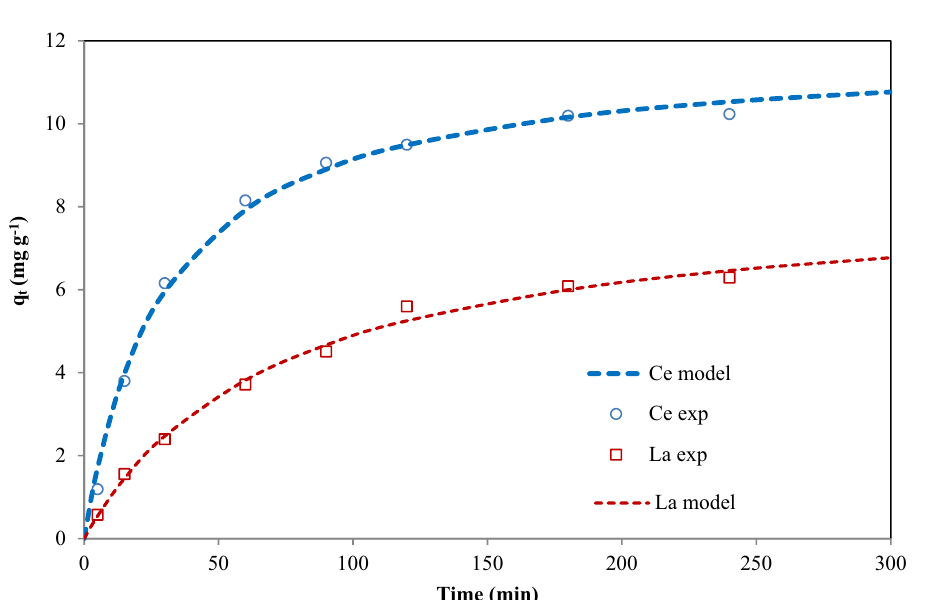
Figure 10 . Nonlinear fit of the pseudo-second order kinetic model of Ce(III) and La(III) ions adsorption onto SIR ([Ce-La] = 200 mg/L, pH = 5, SIR dose = 0.4 g, Stirring velocity = 200 rpm, and temperature = 25 ± 2